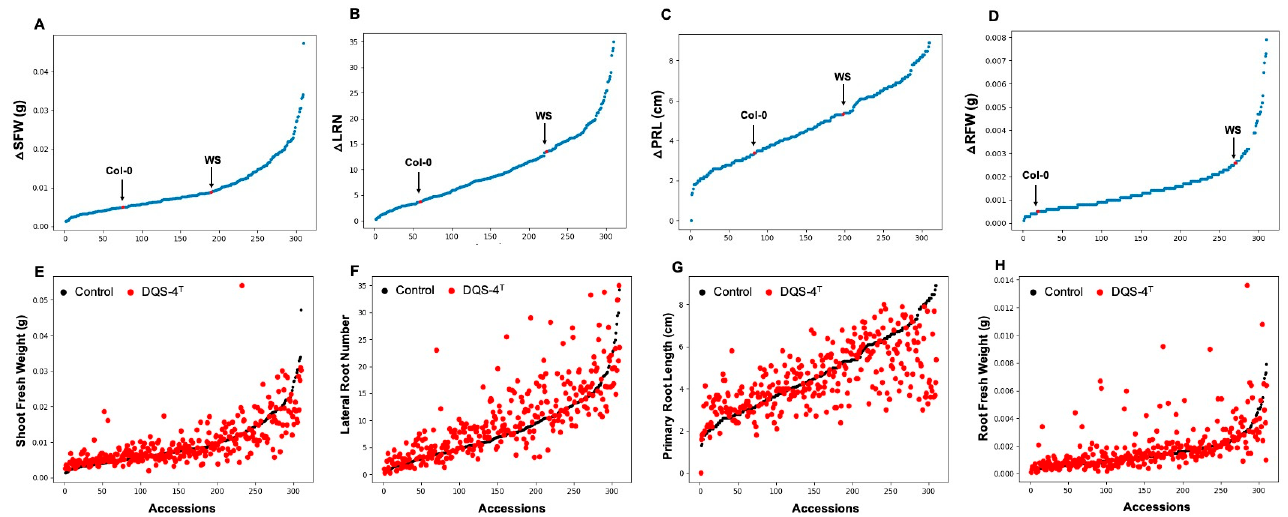
Figure 1. Natural variation in 305 A. thaliana accessions in response to the plant growth-promoting Azoarcus olearius DQS-4 T . ( A ) Accessions sorted for increase in shoot fresh weight ( ∆ SFW) in response to DQS-4T (Col-0 and Ws are indicated with black or red arrow dot). ( B ) Accessions sorted for increase in lateral root number ( ∆ LRN) in response to DQS-4T. ( C ) Accessions sorted for increase in primary root length ( ∆ PRL) in response to DQS-4T. ( D ) Accessions sorted for increase in root fresh weight ( ∆ RFW) in response to DQS-4T. ( E ) Average shoot fresh weight ( ∆ SFW) of control (black dots) and DQS-4T (red dots) plants. ( F ) Number of lateral roots ( ∆ LRN) formed in control (black dots) and DQS-4T-treated (red dots) plants. ( G ) Primary root length ( ∆ PRL) of control (black dots) and DQS-4T (red dots) plants. ( H ) Average root fresh weight ( ∆ RFW) of control (black dots) and DQS-4T (red dots) plants. Each dot represents the average of three biological replicates.